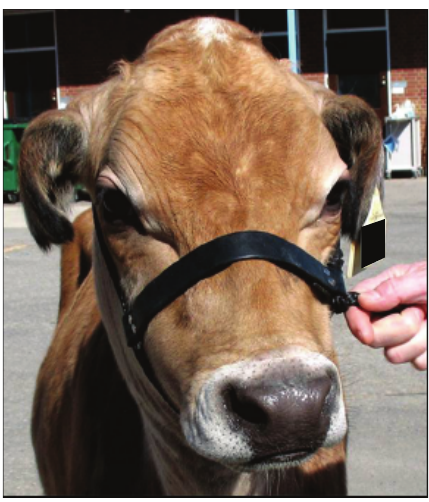
Figure 1: Jersey heifer presented with bilateral droopy ears.